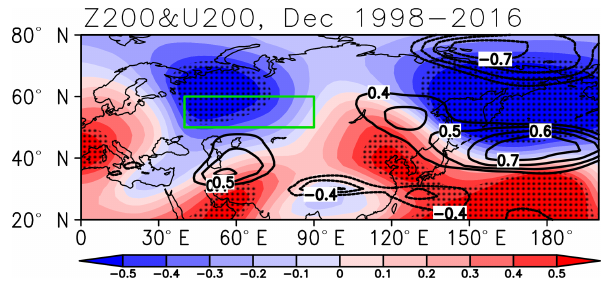
Figure 4. The CC between the SC ES and Z500 (shading, exceeding 90, 95, and 99% confidence levels), stream function (contour), and wave activity flux (arrow) in December from 1998 to 2016. The green box represents the ES area. The linear trend is